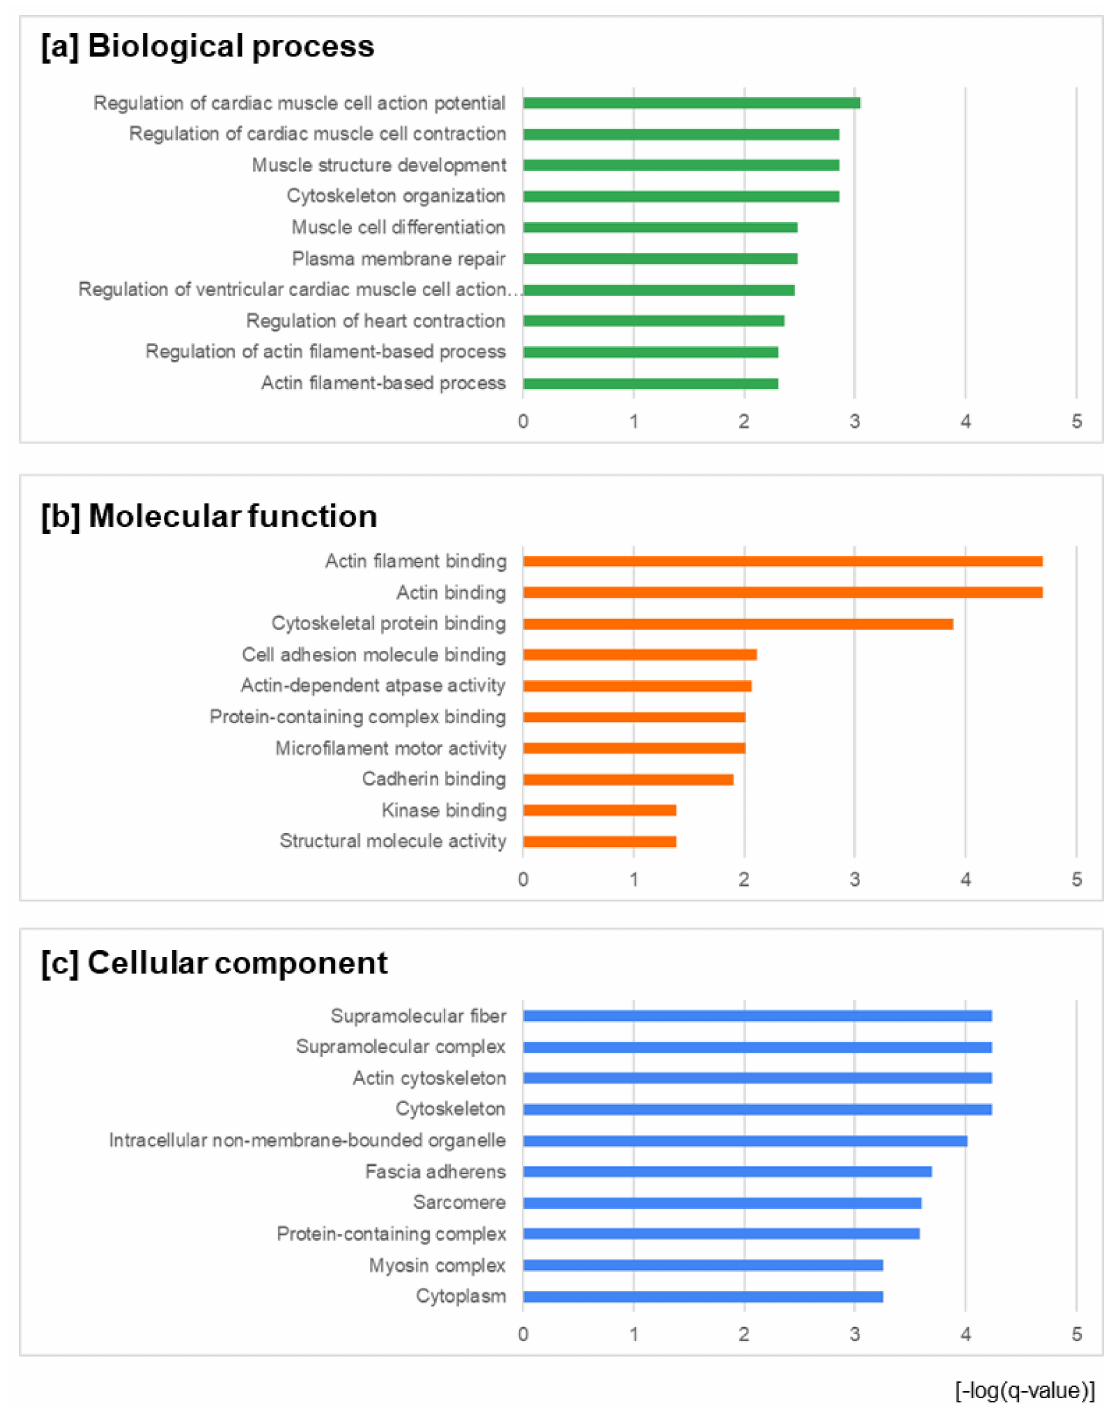
Figure 2. Gene ontology enrichment analysis of the identified differentially-expressed proteins in three categories: ( a ) biological process; ( b ) molecular function; and ( c ) cellular components. The abscissa was the –log (q-value) in order to show the significance between the proteins involved in feature function and annotation; this parameter describes the significance of the enrichment. The displayed q-values are corrected FDR values for multiple testing within each category, for which the Benjamini–Hochberg procedure was